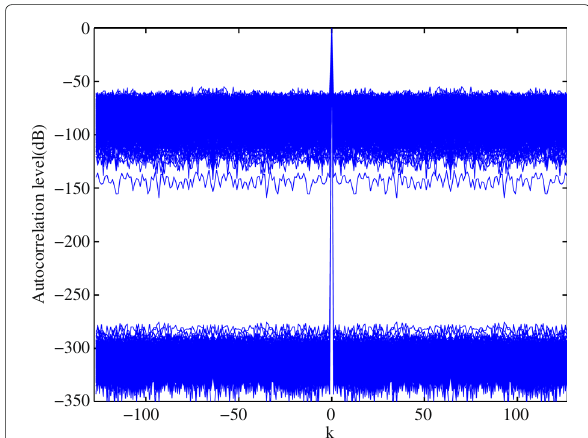
Fig. 1 Autocorrelation level of the sequences generated by PeCAN